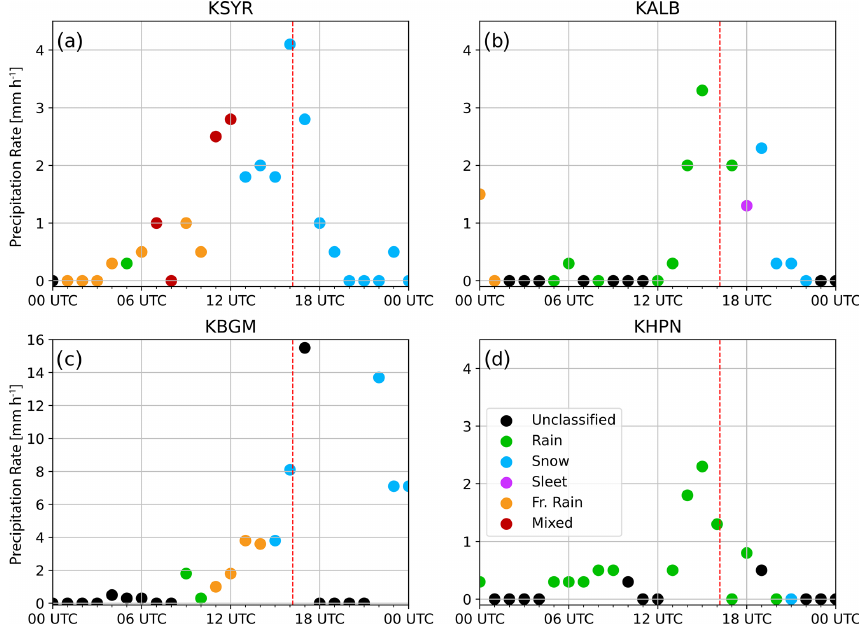
Figure 4. Hourly ASOS precipitation rate and type [mmh − 1 ] reports for 7 February 2020 from (a) KSYR, (b) KALB, (c) KBGM, and (d) KHPN. Colors indicate precipitation type as in the legend in panel (d) . The dashed red line indicates 16:09:11UTC, highlighted in Fig. 2. The y -axis range is larger in panel (c) than in the other